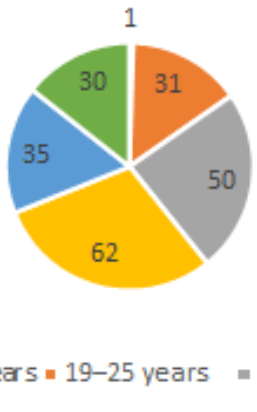
Figure 2. Respondents by age.